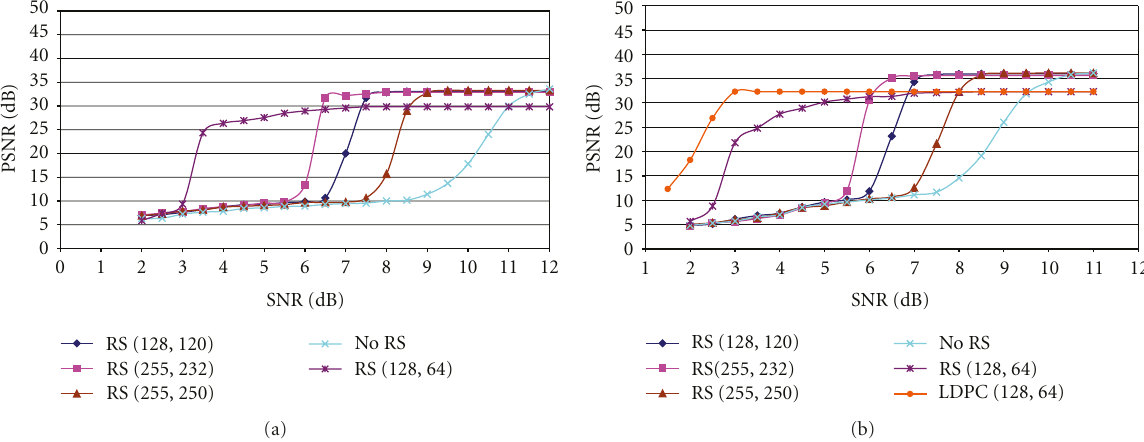
Figure 15: PSNR evolution for “Mobile Calendar” sequence in CIF resolution and “Foreman” sequence in QCIF resolution over BSC channel for di ff erent protection levels (RS or LDPC codes) and redundancy NAL unit headers protected.